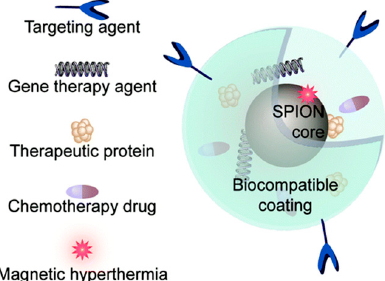
Figure 1. Architecture of second-generation iron-based nano-theranostics. Reproduced from “Surface Engineering of Iron Oxide Nanoparticles for Targeted Cancer Therapy”, with permission from American Chemical Society, 2011.